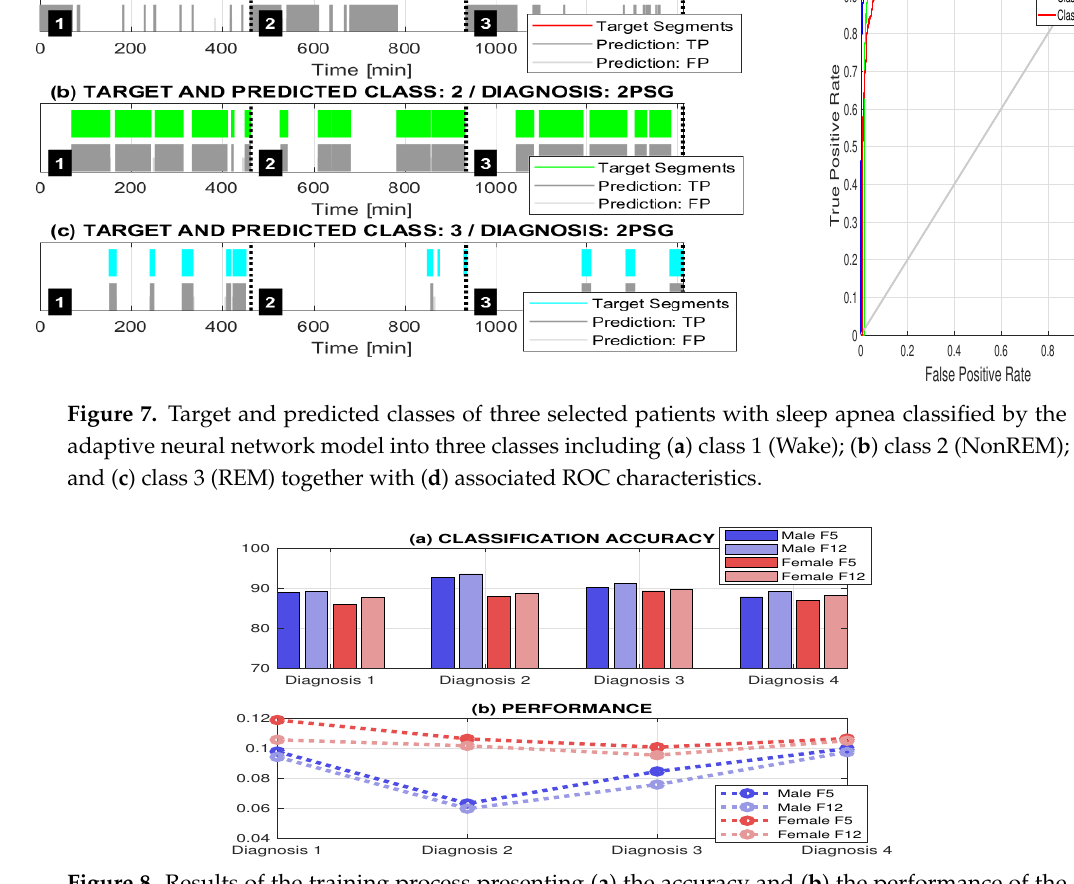
Figure 8. Results of the training process presenting ( a ) the accuracy and ( b ) the performance of the resulting model for different sleep disorders for sets of male and female individuals using EEG (F5) and multimodal EEG, Flow and OCG (F12) features. Table 8. Classification accuracy and the 10-fold cross-validation errors of the sets of males and females and precision of individual classes over all sleep disorders for 5 (F5) mean EEG power features and 12 (F12) features with an additional 4 features evaluated from the flow and electro-oculogram